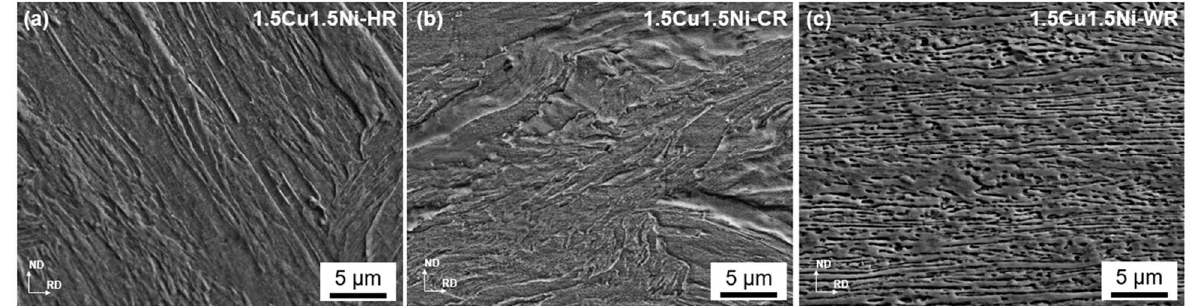
Figure 5. The morphologies of 1.5 Cu1.5Ni MMnS after ( a ) hot rolling, ( b ) cold rolling, and ( c ) warm rolling.